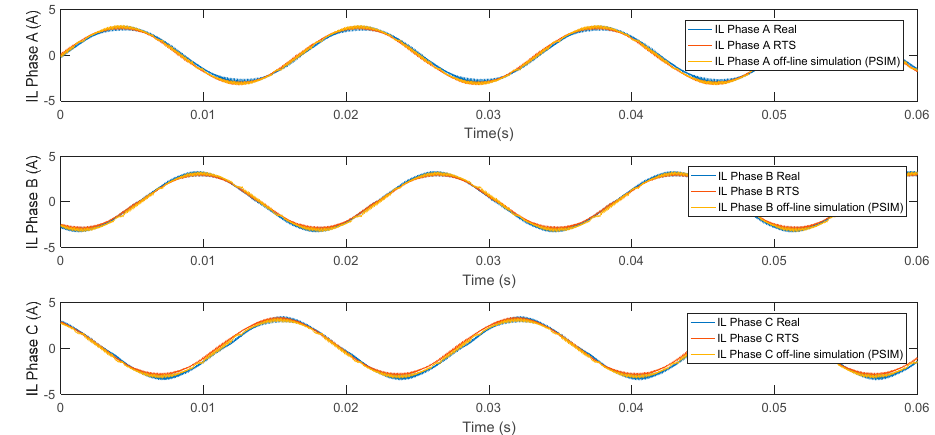
Figure 16. Phase current of the three-phase VSI, real-time simulation and PSIM.